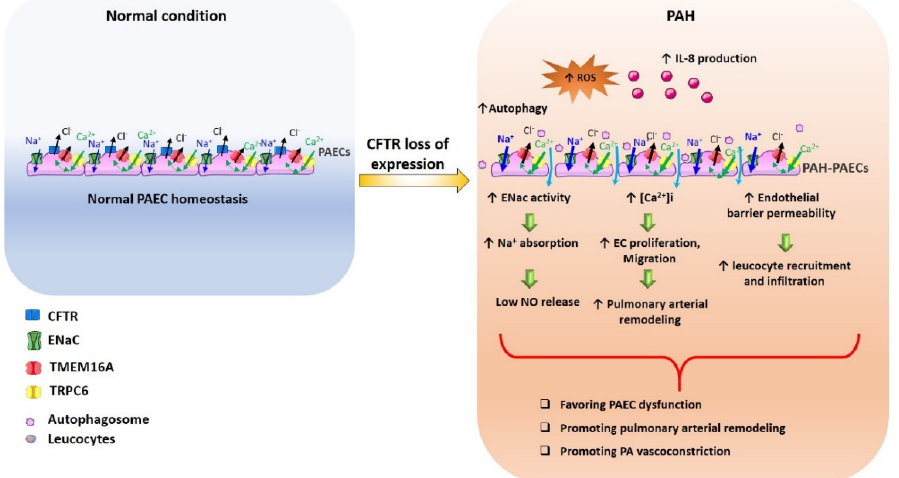
Figure 5. Proposed signaling events arising from CFTR dysfunction in PAECs in PAH. Cystic fibro- sis transmembrane conductance regulator (CFTR); epithelial Na + channels (ENaC); nitric oxide (NO); pulmonary arterial hypertension (PAH); pulmonary artery (PA); pulmonary artery endothe- lial cell (PAEC); reactive oxygen species (ROS).